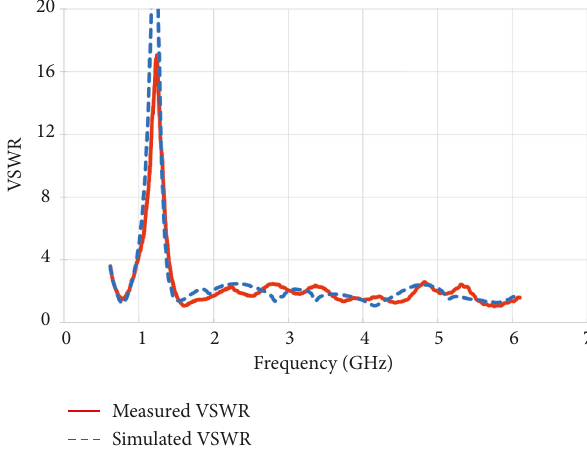
Figure 10: Proposed antenna simulated and measured